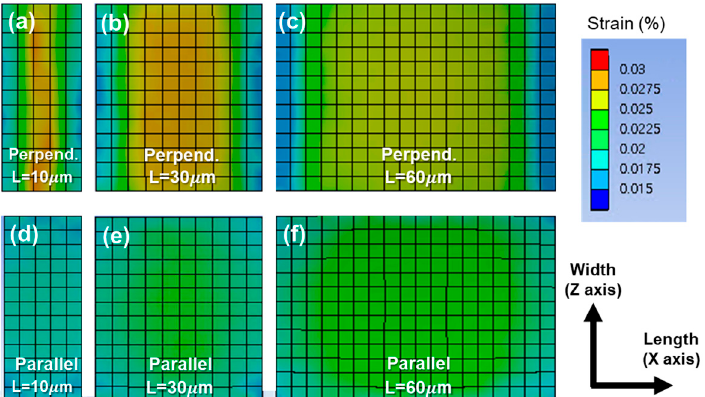
Figure 3. Strain distributions at the bottom of the active layer in a device with various channel lengths under perpendicular or parallel bending: ( a , d ) 10 µm; ( b , e ) 30 µm; and ( c , f ) 60 µm.